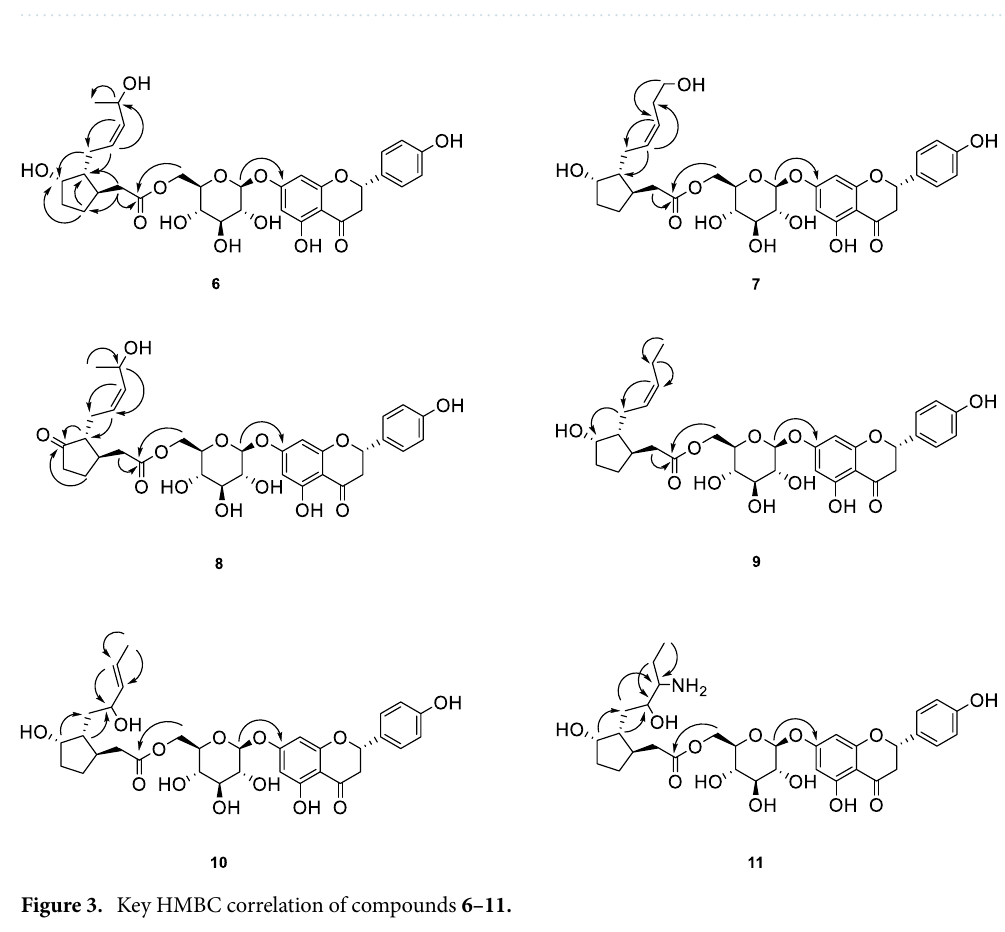
Figure 3. Key HMBC correlation of compounds